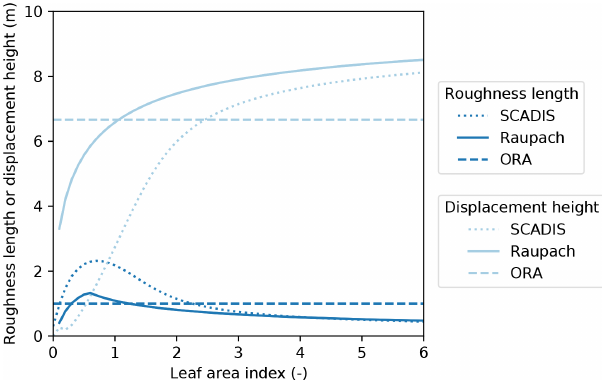
Figure 3. Response of the different roughness length and displace- ment height models to leaf area index (LAI) for a forest with h = 10m. The SCADIS model is set up with α = 9 and β = 3, which are typical values for forests with most of the canopy den- sity in the upper part of the canopy layer (Sogachev et al.,